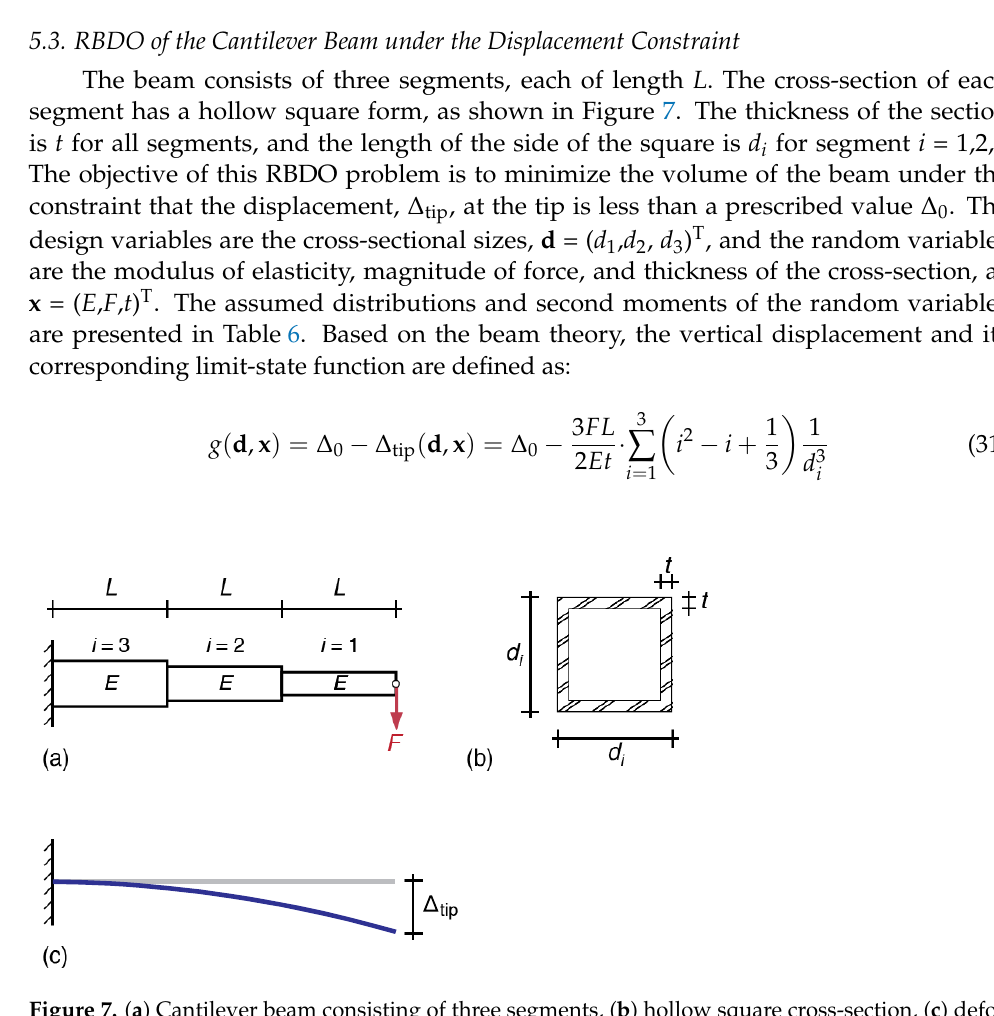
Figure 7. ( a ) Cantilever beam consisting of three segments, ( b ) hollow square cross-section, ( c ) deformation under a vertical force. Table 6. Description of the random variables for the cantilever beam